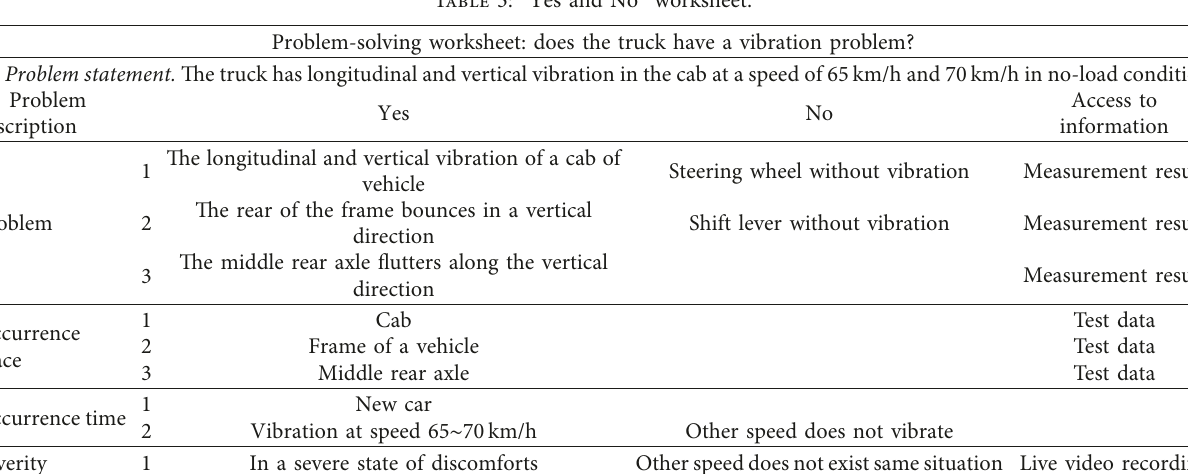
Figure 2: “5Whys” method to determine the root cause. Table 3: “Yes and No” worksheet.